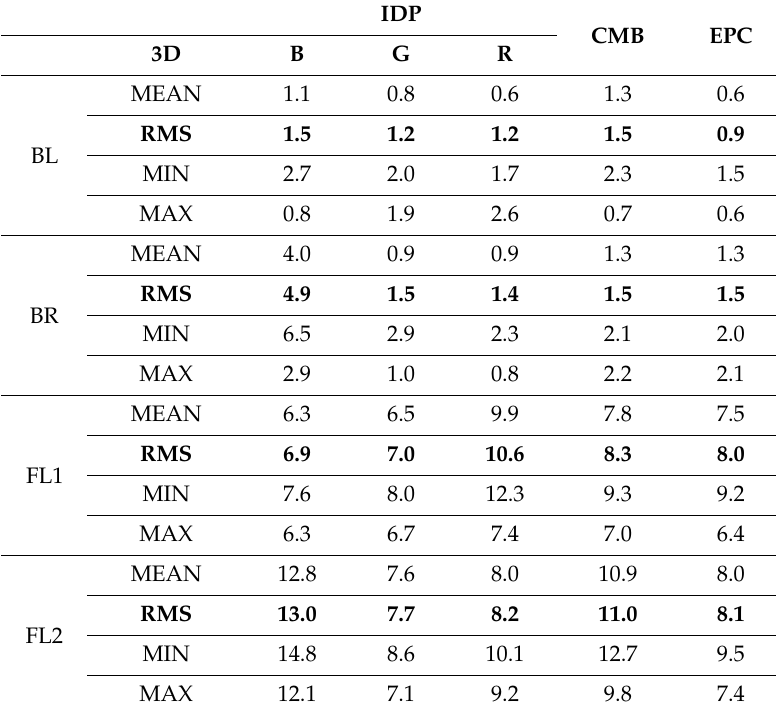
Table 10. The 6EOP accuracy assessment results. All results are shown in